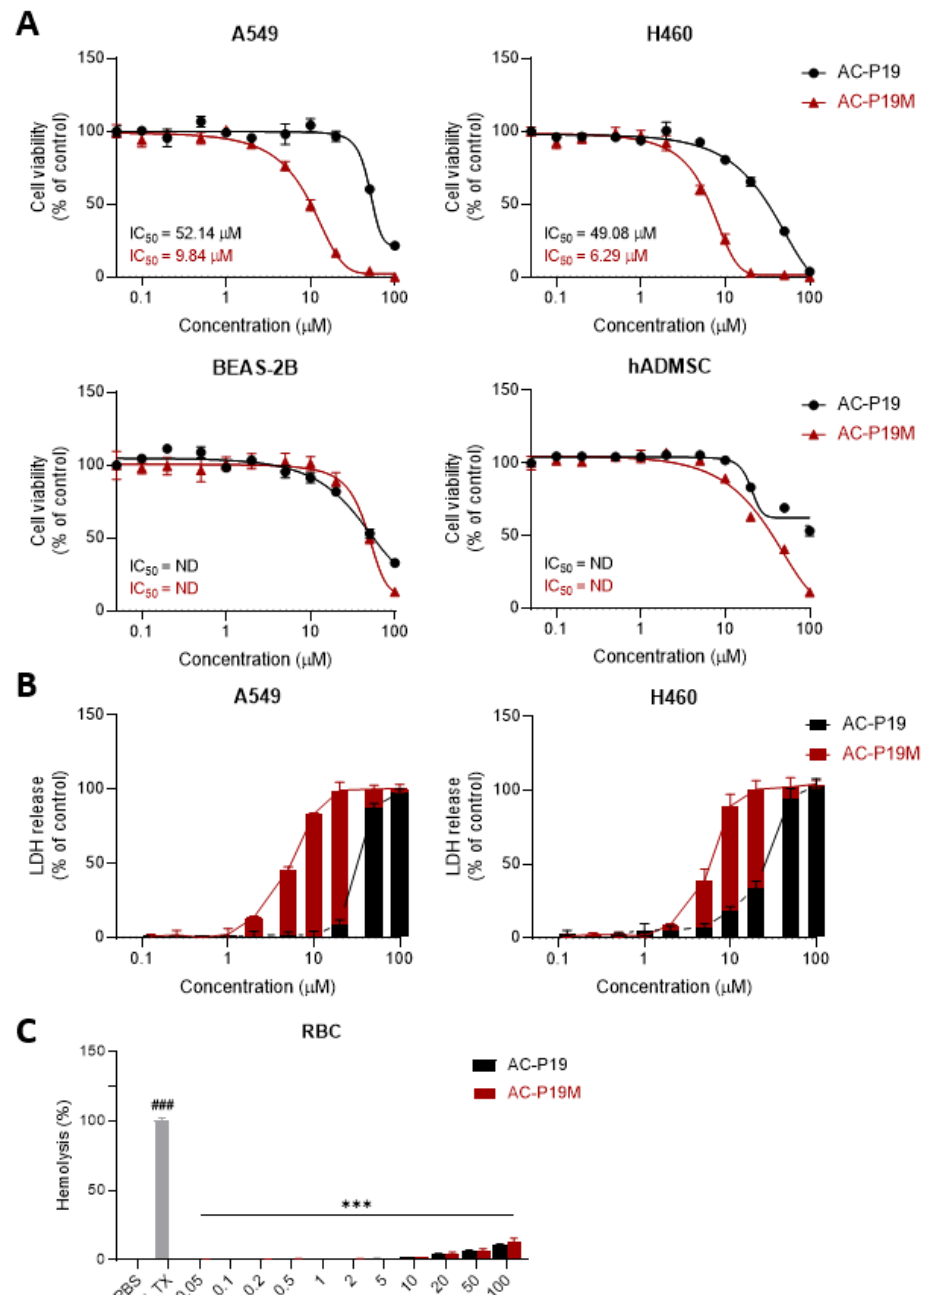
Figure 2. Anticancer activities of the peptides AC-P19 and AC-P19M. ( A ) The relative cell viability of lung cancer cells and normal cells was examined after AC-P19 and AC-P19M treatments at concentrations ranging from 0.1 µ M to 100 µ M. Lung cancer cells were more susceptible to peptide treatment than normal cells, and the decrease in cancer cell viability was higher in the AC-P19M- treated group. ( B ) The cytotoxic effects of the peptides on lung cancer cells were confirmed through an LDH release assay. The analyses were conducted for a range of peptide concentrations between 0.1 μ M and 100 μ M. LDH release at levels comparable to the positive control (0.1% Triton X-100; 0.1% TX) was obtained with a lower concentration of AC-P19M compared with AC-P19. ( C ) For both peptides (up to 100 μ M), hemolysis was observed to be lower than 15% of that observed upon treatment with 0.1% TX. Data are presented as the mean ± SEM. ###, p < 0.001 compared to the control group; ***, p < 0.001 compared to the 0.1% TX-treated group.